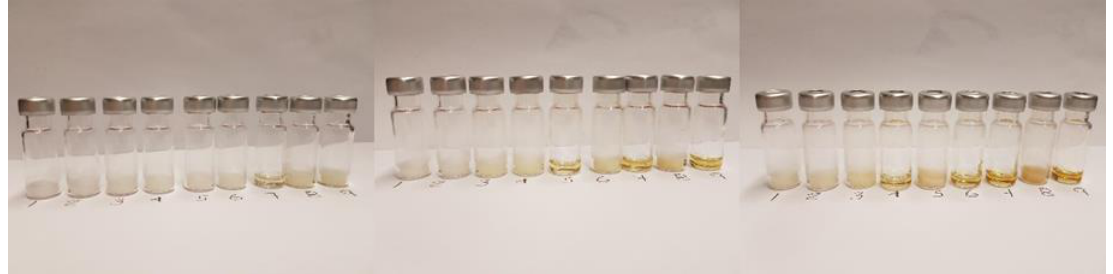
Figure 7. Samples of pure erythritol under air for short term at (from left to right) 121 °C, 131 °C and 141 °C.